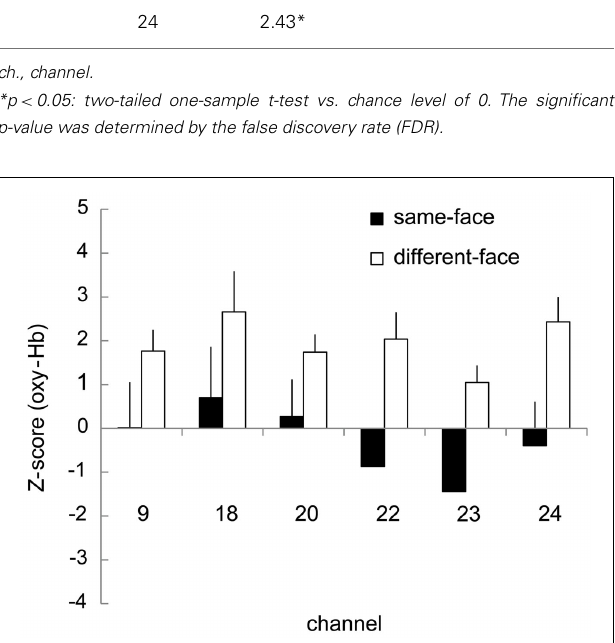
FIGURE 8 | Mean Z -scores of the six channels (ch. 9, 18, 20, 22, 23, 24) selected as COI in the same-face and the different-face conditions, respectively. The vertical line in each graph represents 1 SE. All of these channels showed higher Z -scores in the different-face condition than in the same-face condition for oxy-Hb.The main effect of condition was significant with 2 (condition) × 5 (channel) ANOVA ( p <